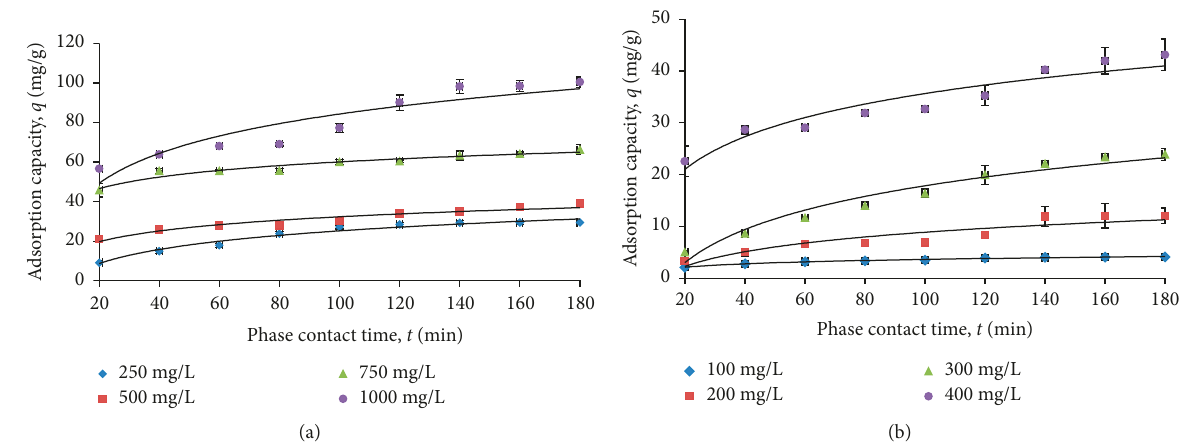
Figure 1: Kinetic of (a) octanoic acid and (b) hexanoic acid adsorption onto a weak base ion exchange resin (Amberlite IRA 67) at different organic acid concentrations. Graph represents the mean of three replicate samples with error bars. Table 1: Values of adsorption extent, Peleg’s constants ( K root mean squared deviation (RMSD) at different initial concentrations.